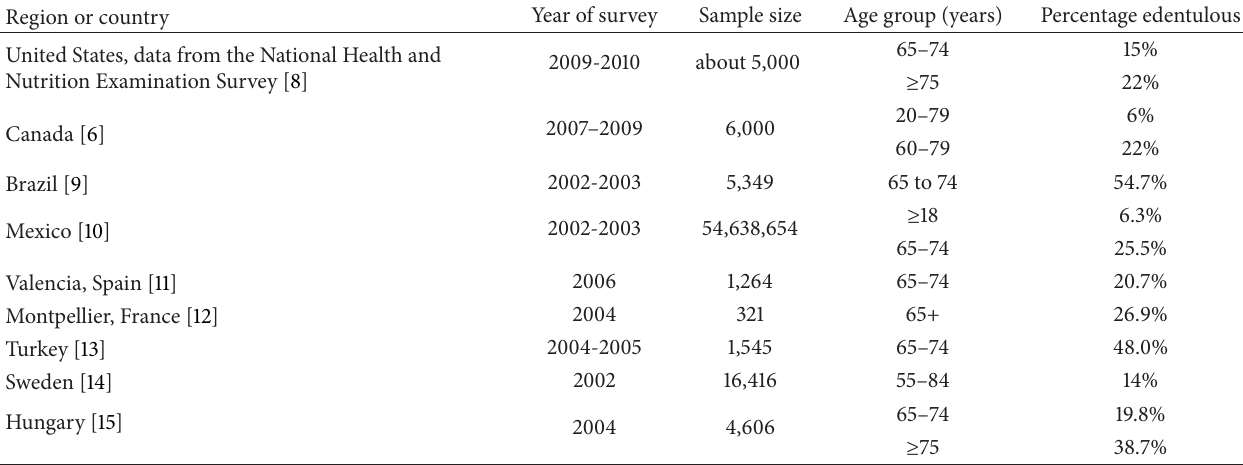
Table 1: Prevalence of edentulism in the elderly from different